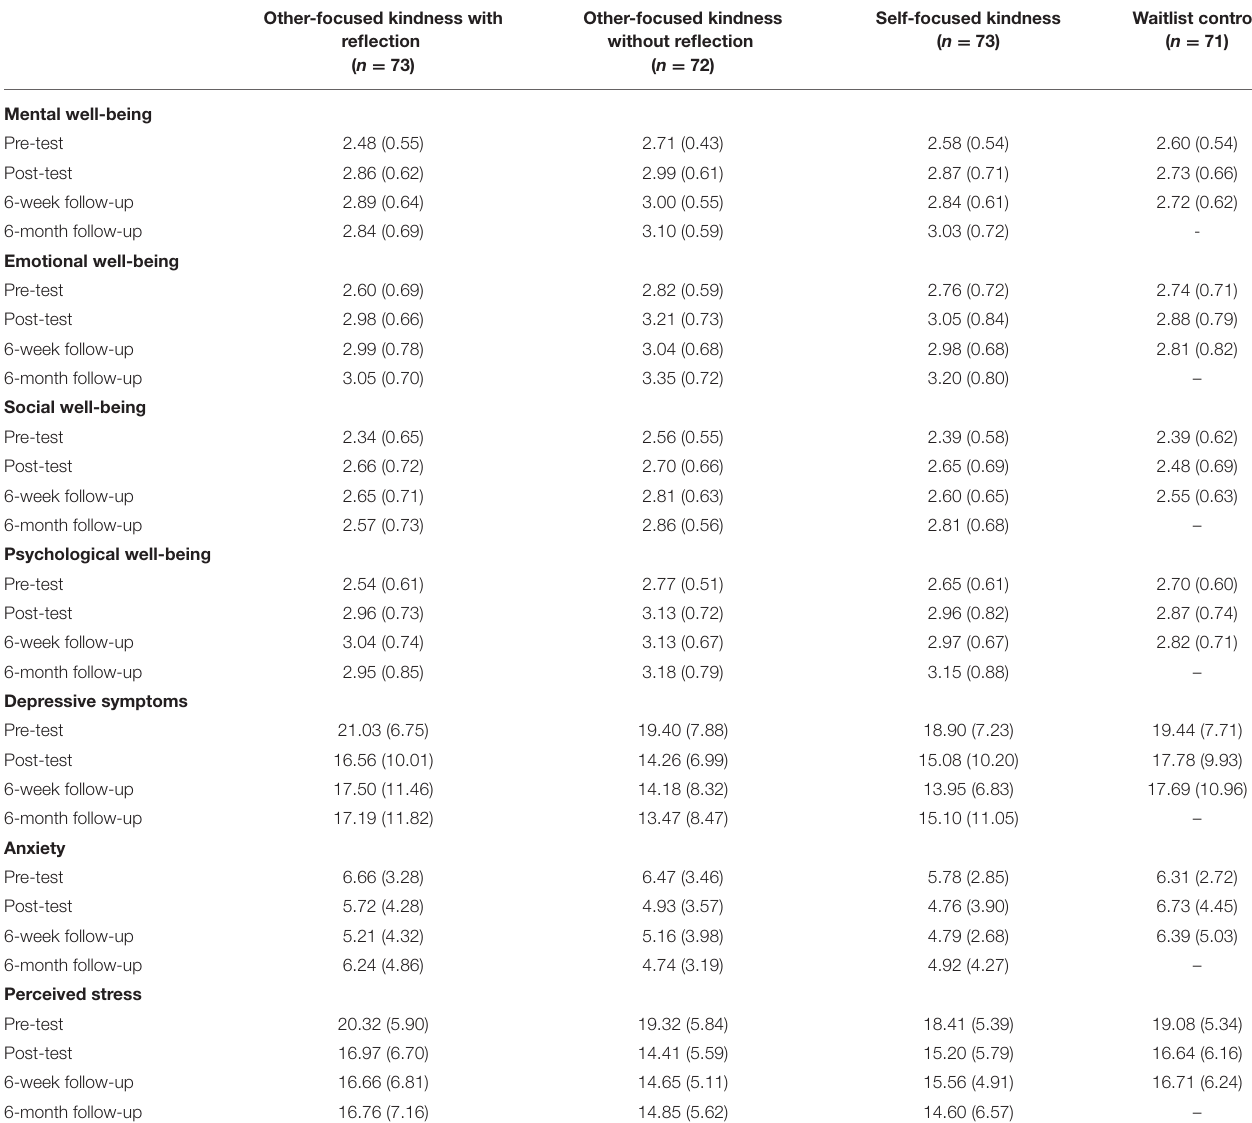
TABLE 2 | Means (SDs) for mental health outcomes on each assessment by condition.